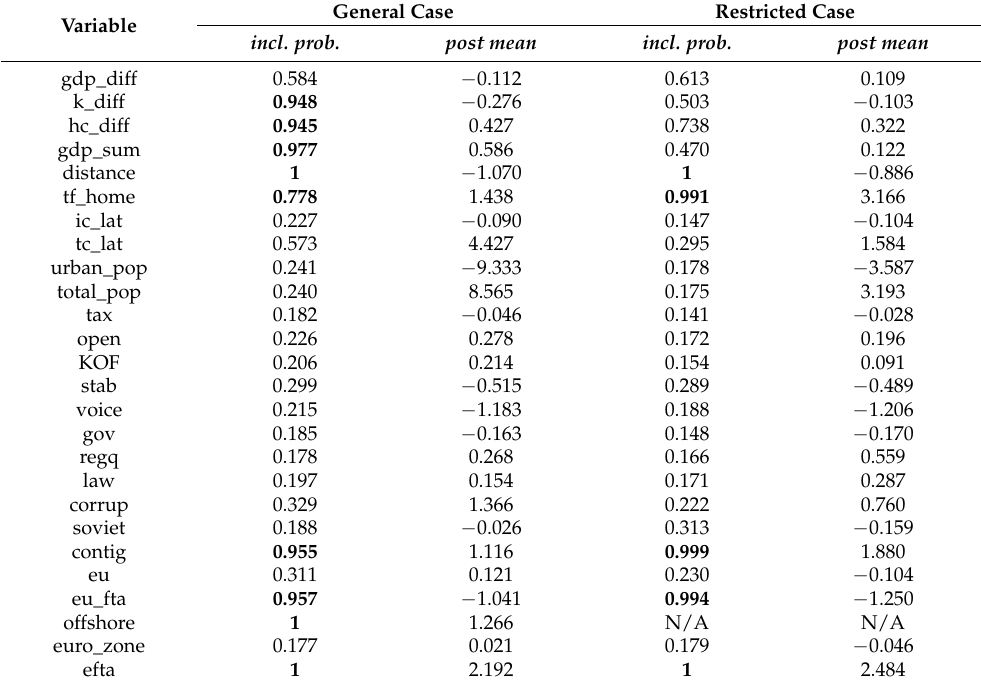
Table A6. Determinants of inward FDI in Latvia